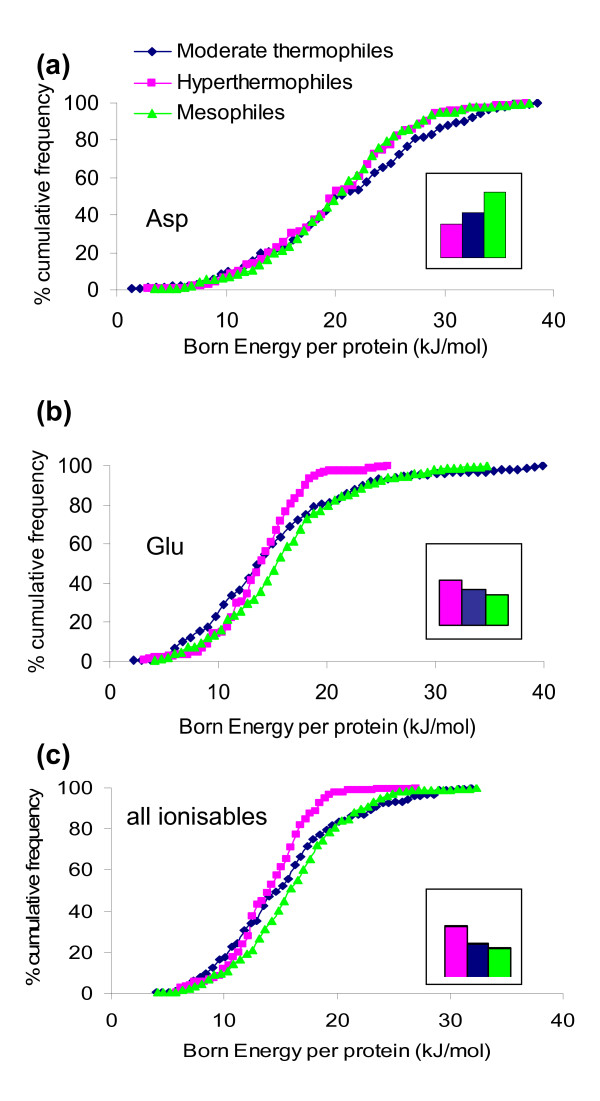
Separation by Born (desolvation) energy of ionisable groups, summed over each protein. (a) Aspartic acid. The inset in this and other panels shows the relative composition for the given amino acid(s). Thus aspartic acid is most common in mesophiles and least in hyperthermophiles. (b) Glutamic acid. (c) All ionisable groups likely to be charged at neutral pH.